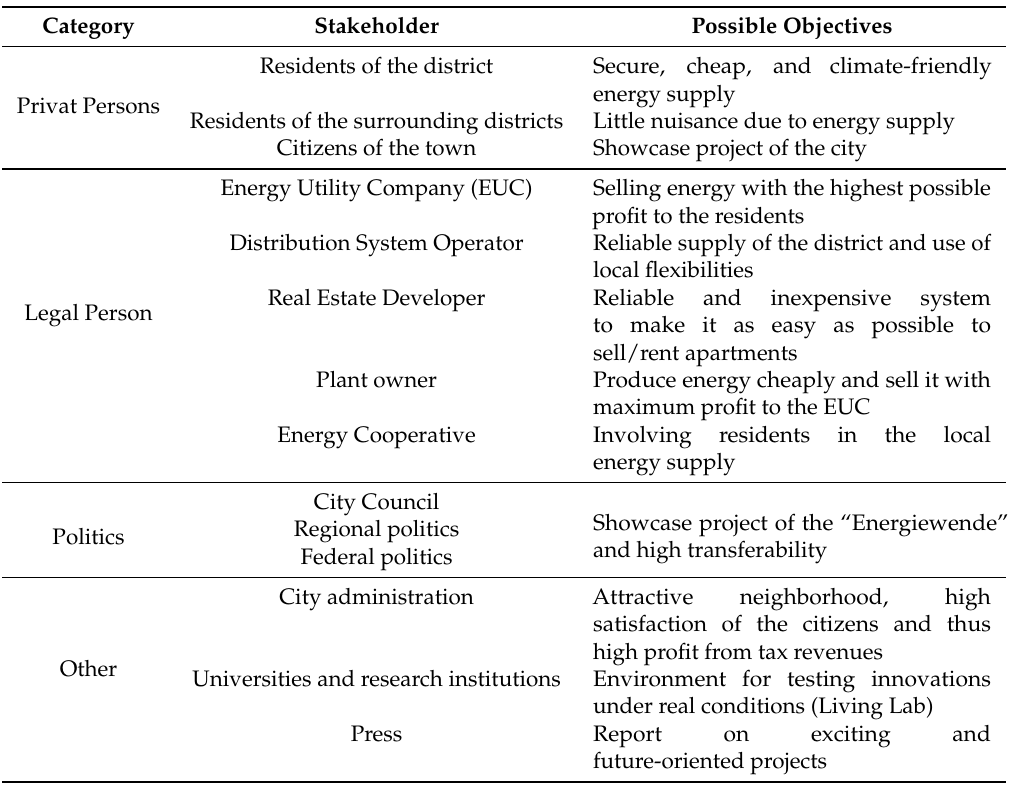
Table 1. Overview of the main stakeholders for the present case study and qualitative description of their possible objectives. This list does not claim to be exhaustive or transferable to other projects but is merely intended to give an impression of the complexity and multilayeredness of the decision-making processes for district energy